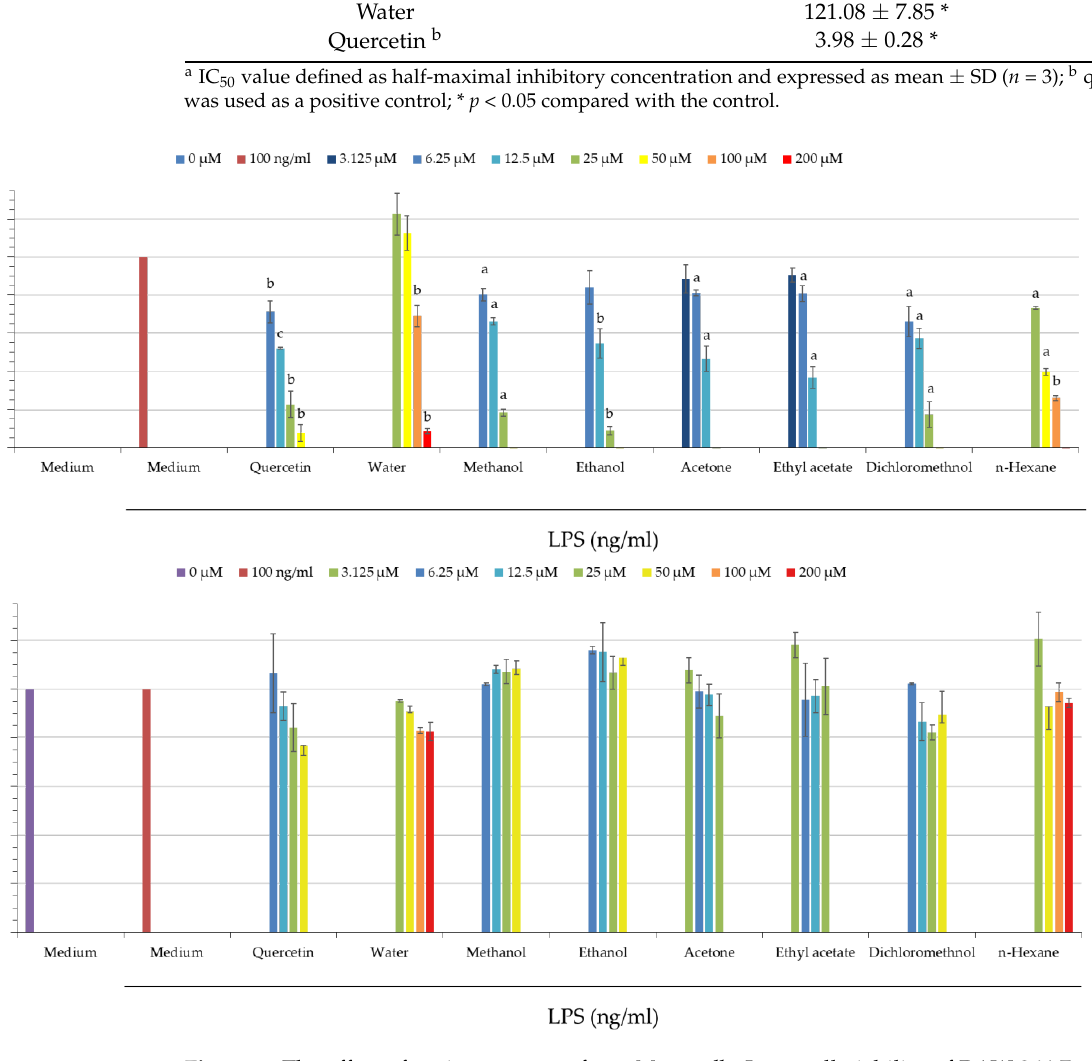
Figure 1. The effect of various extracts from Morus alba L. on cell viability of RAW 264.7 cells was assessed by MTT assay. Values are expressed as mean ± SD ( n = 3); quercetin was used as a